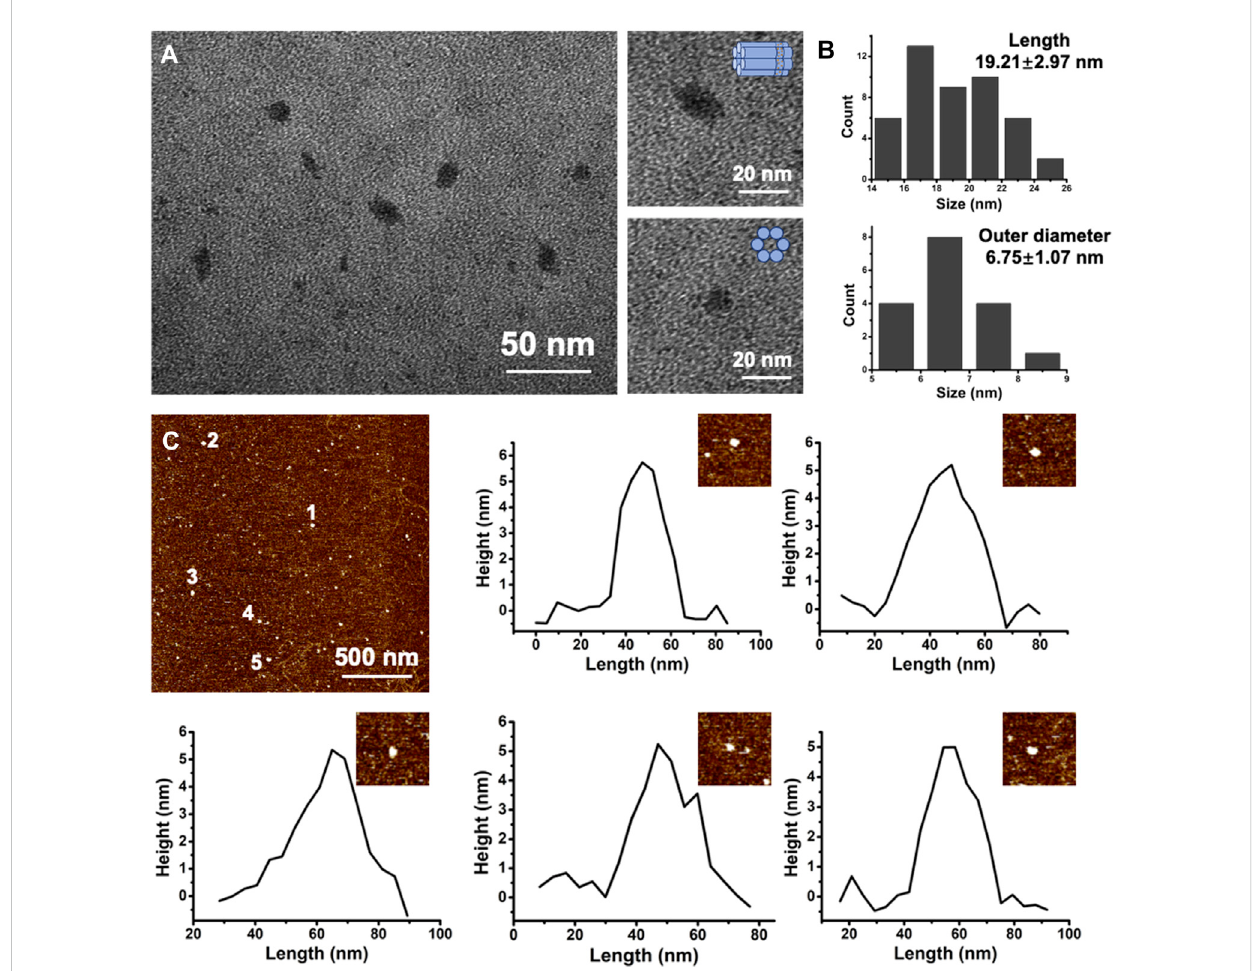
FIGURE 2 (A) Representative TEM image of E-DNA nanopores. Scale bar: 50 nm. High-magni fi ed TEM images of single E-DNA nanopores of different positions.Scalebar:20 nm. (B) StatisticresultsofthelengthandouterdiameterofE-DNAnanopores( n =46forlengthand n =17forouterdiameter).